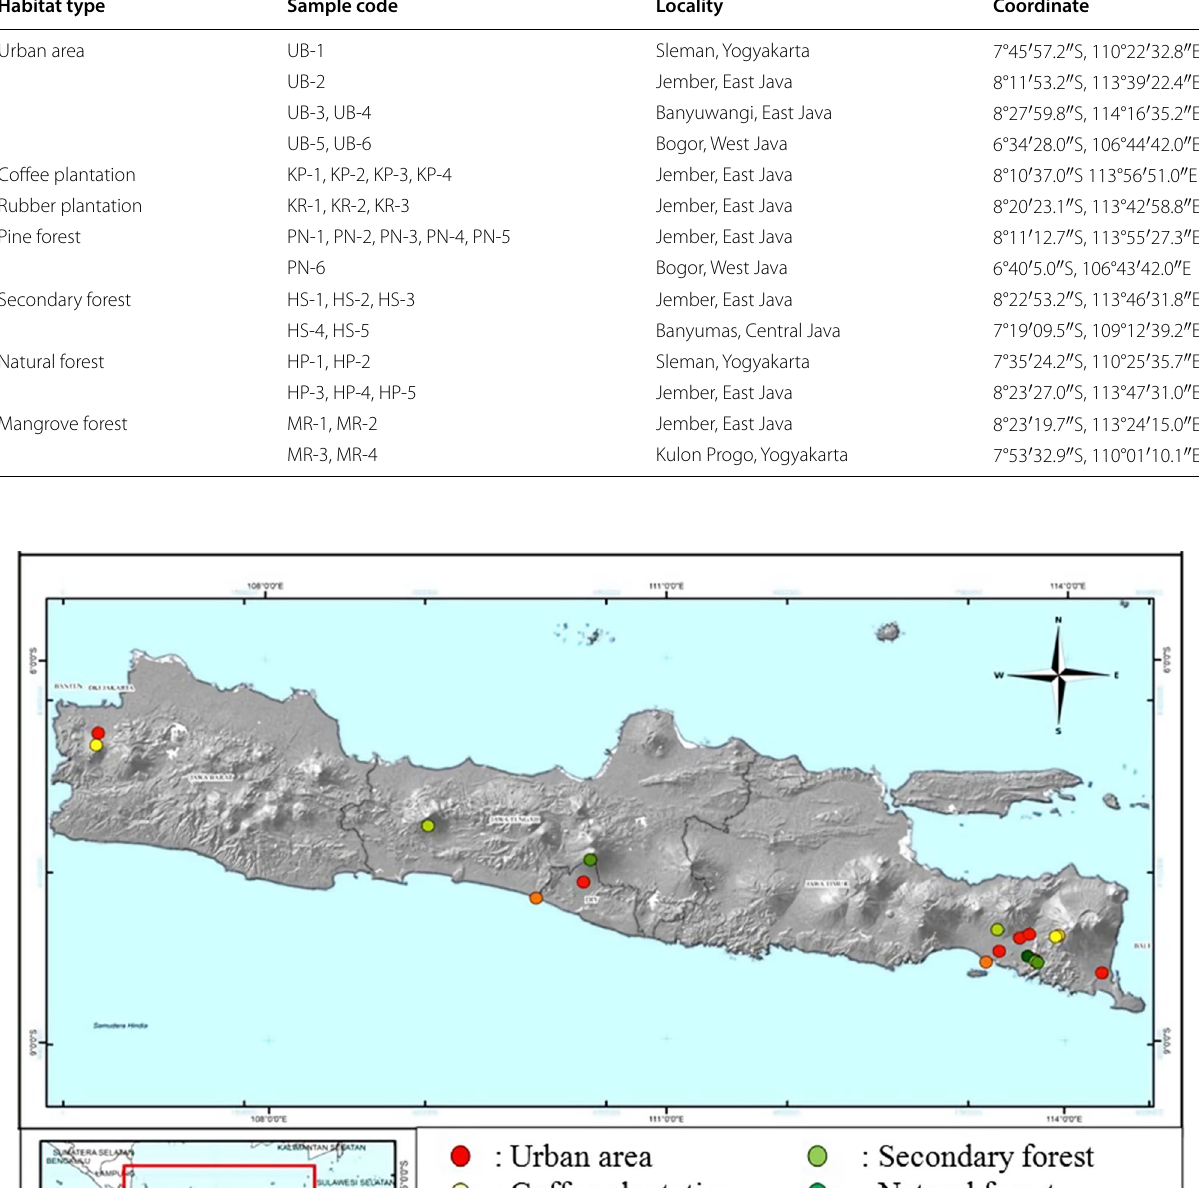
Table 1 Habitat type, sample code, and locality of sample collection in this study Habitat type